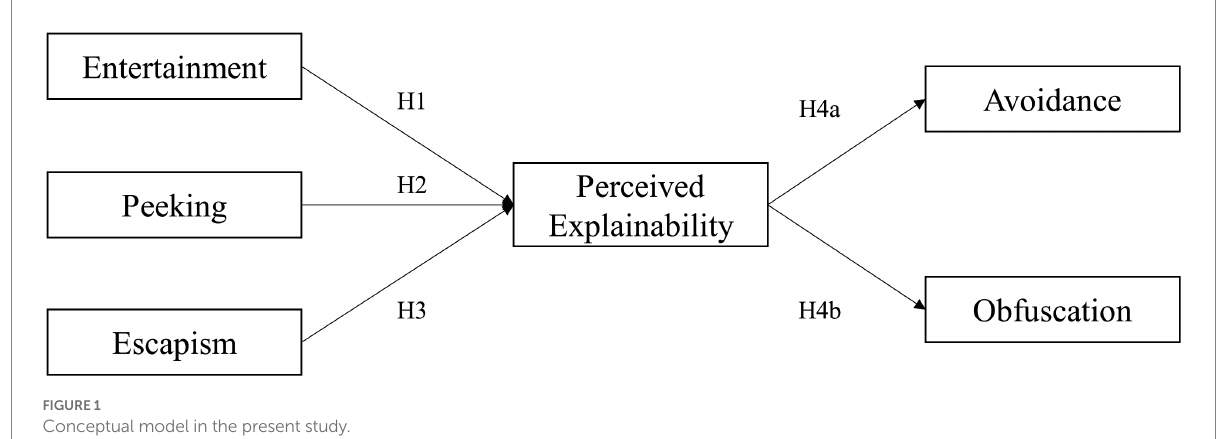
FIGURE 1 Conceptual model in the present study.